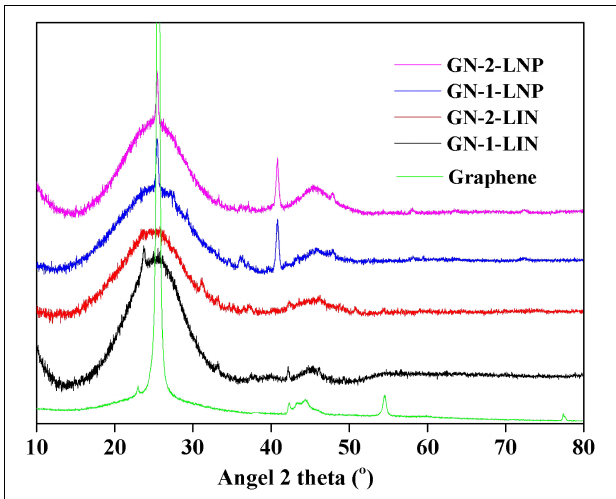
FIGURE 4 | XRD patterns of the prepared carbons and commercial graphene.